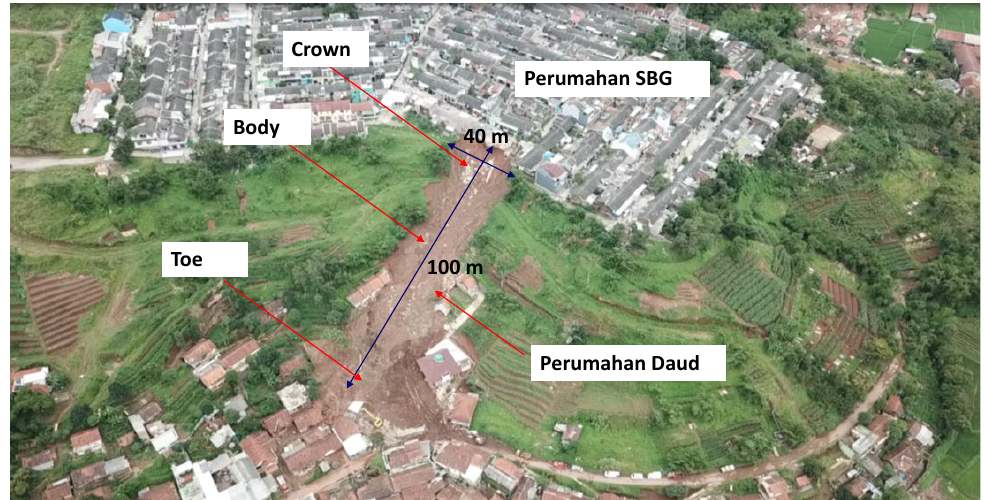
Figure 1. Post-failure slope conditions.